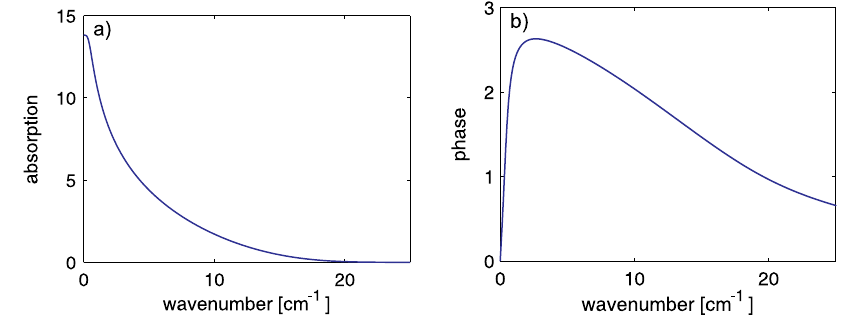
FIG. 5. (a) Absorption and (b) derived phase modulation as a function of wave number.